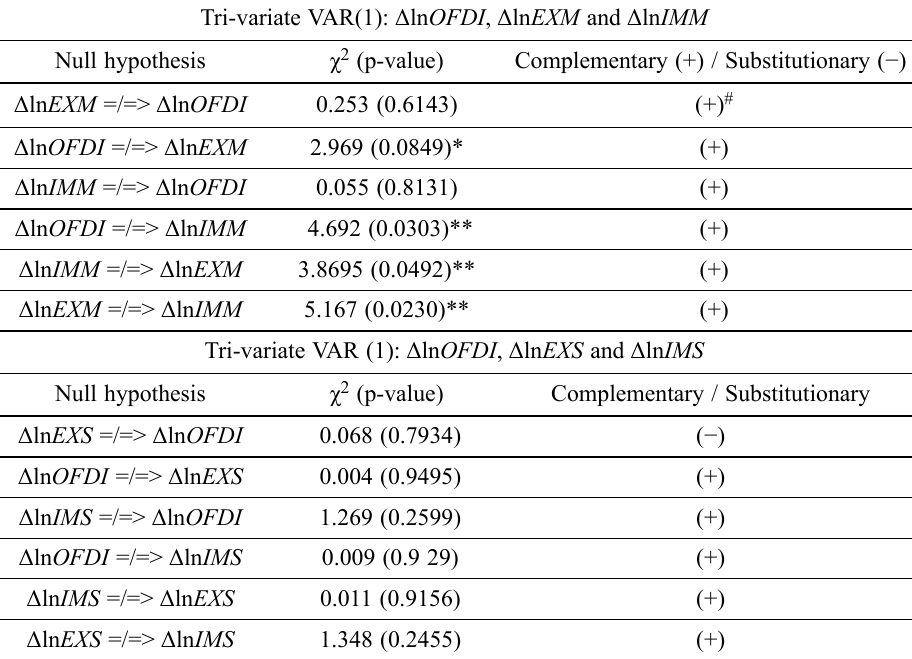
Table 10. Causality tests for OFDI, exports and